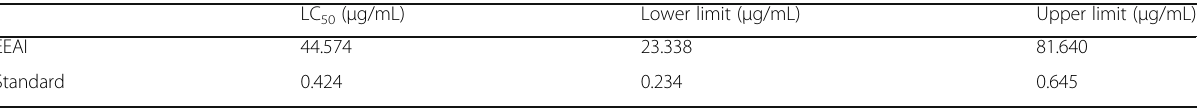
Table 4 LC 50 for EEAI and standard with lower and upper limit calculated by Ldp line software LC 50 ( μ g/mL) Lower limit ( μ